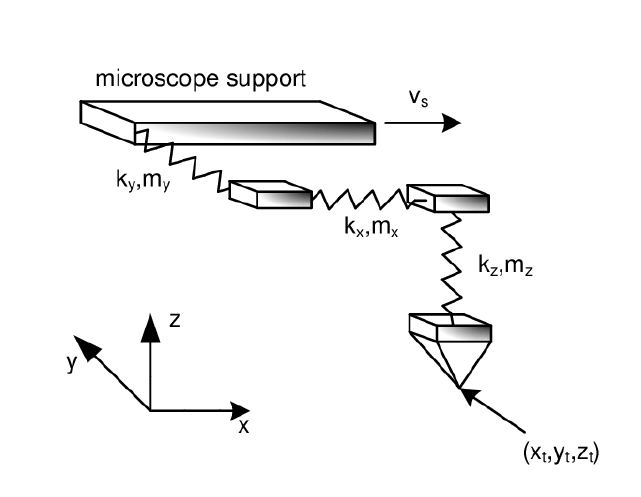
Figure 1 Model of AFM, FFM adn AFM